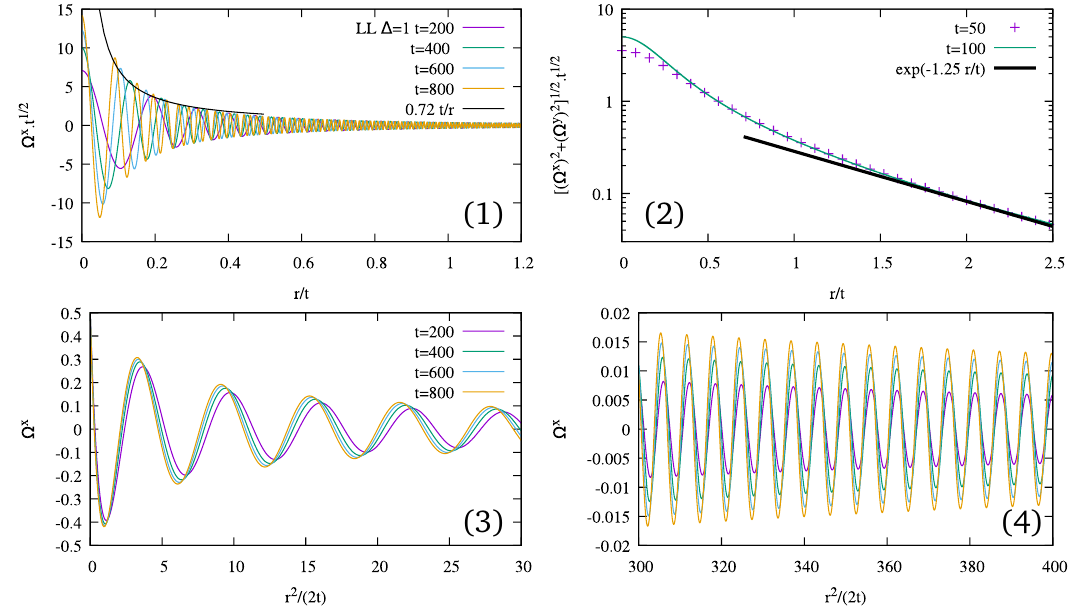
(cid:112) t for ∆ = 1 as a function of r / t (LL). With this scaling the Figure 4: Panel 1 : Ω x different curves ( t = 200, 400, 600 and 800) appear to have the same envelope. The thin black line is a fit of the envelope in the region where r is of the order of (cid:112) t appears to scale as ∼ t / r . Panel 2: small r / t ). In this region, the envelope of Ω x (cid:112) (cid:112) ( Ω x ) 2 + ( Ω y ) 2 t in log scale. The thick black line is a fit in the region of large r / t , where the amplitude of the magnetization in the x − y plane decays exponentially. (cid:112) ( Ω (cid:112) x ) 2 + ( Ω y ) 2 = This plot suggests that 1 / 4 − ( Ω z ) 2 scales as exp ( − cr / t ) /